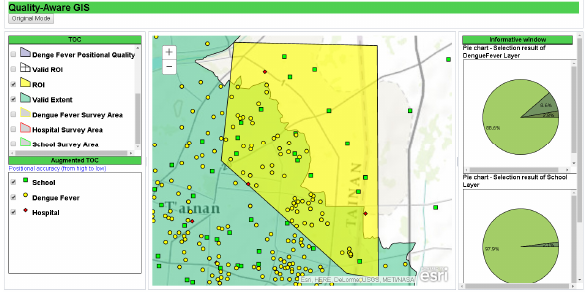
Figure 10. ROI (yellow area) and Valid extent (green area)